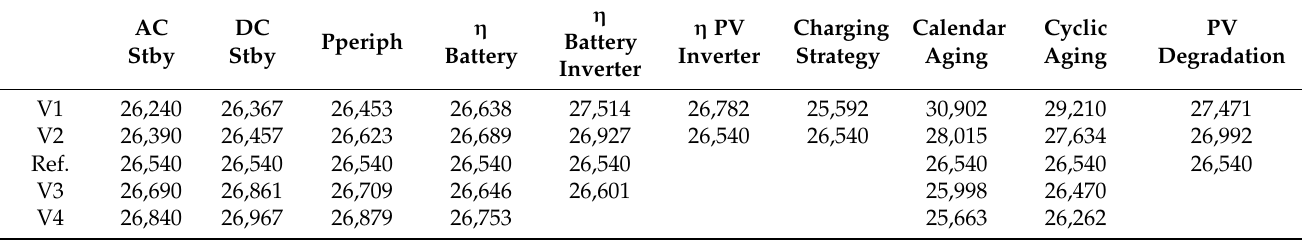
Table A5. Total electricity costs over a period of 20 year in € depending on the change of different technical parame- ters. The selected PV system and battery combination is the combination that is the most favorable for the respective boundary conditions.